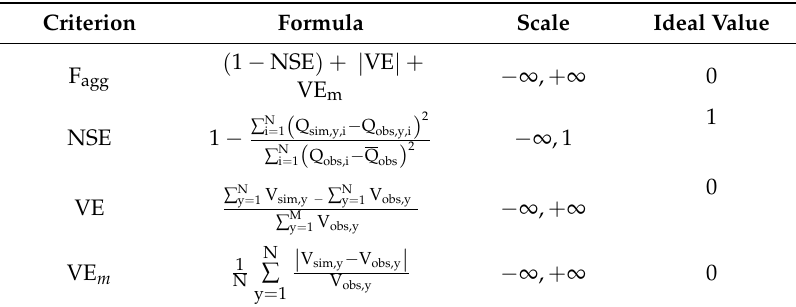
Table 4. The hydrological calibration